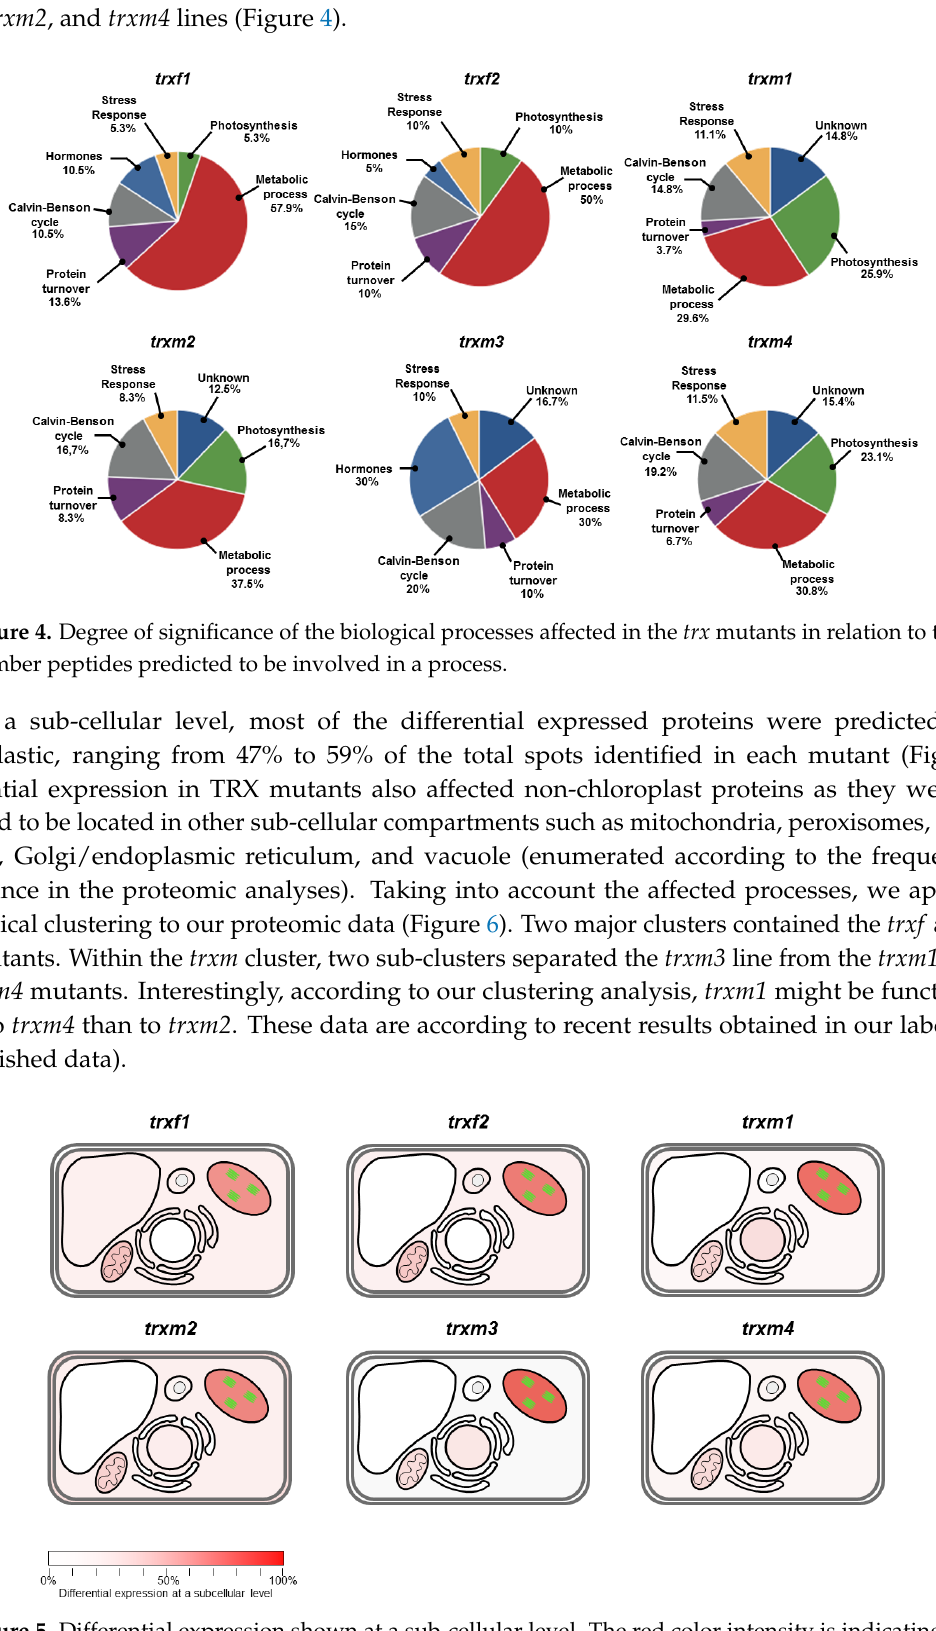
Figure 6. Hierarchical clustering segregates trx mutants according to the biological processes affected. For calculations, the R statistical environment (The R Foundation, Vienna, Austria) available at http://www.R-project.org was used. 4. Discussion The existence of an elevated number of plastidial thioredoxins, amongst which are two f type TRXs and four m type TRXs in the chloroplast makes it difficult to identify and separate their different functions. A great deal of effort has been made to reach important conclusions and different authors have reported previously protein targets and suggested specific roles for several of the plastidial TRXs. Due to similarities with the f and m type TRXs, these isoforms might both carry out overlapping as specific functions in the redox regulation of the plant physiological processes. However, it has been difficult to find a clear border to delimit the role of each plastidial TRX described up to now. Beyond the study of the different reduction degree of the target proteins, our aim has been to know whether the pattern response of the Arabidopsis proteome is specific for each plastidial TRX mutant characterized. In this study we have carried out a proteomic profile of Arabidopsis mutant lines lacking f1 , f2 , m1 , m2 , m3 and m4 type TRXs.